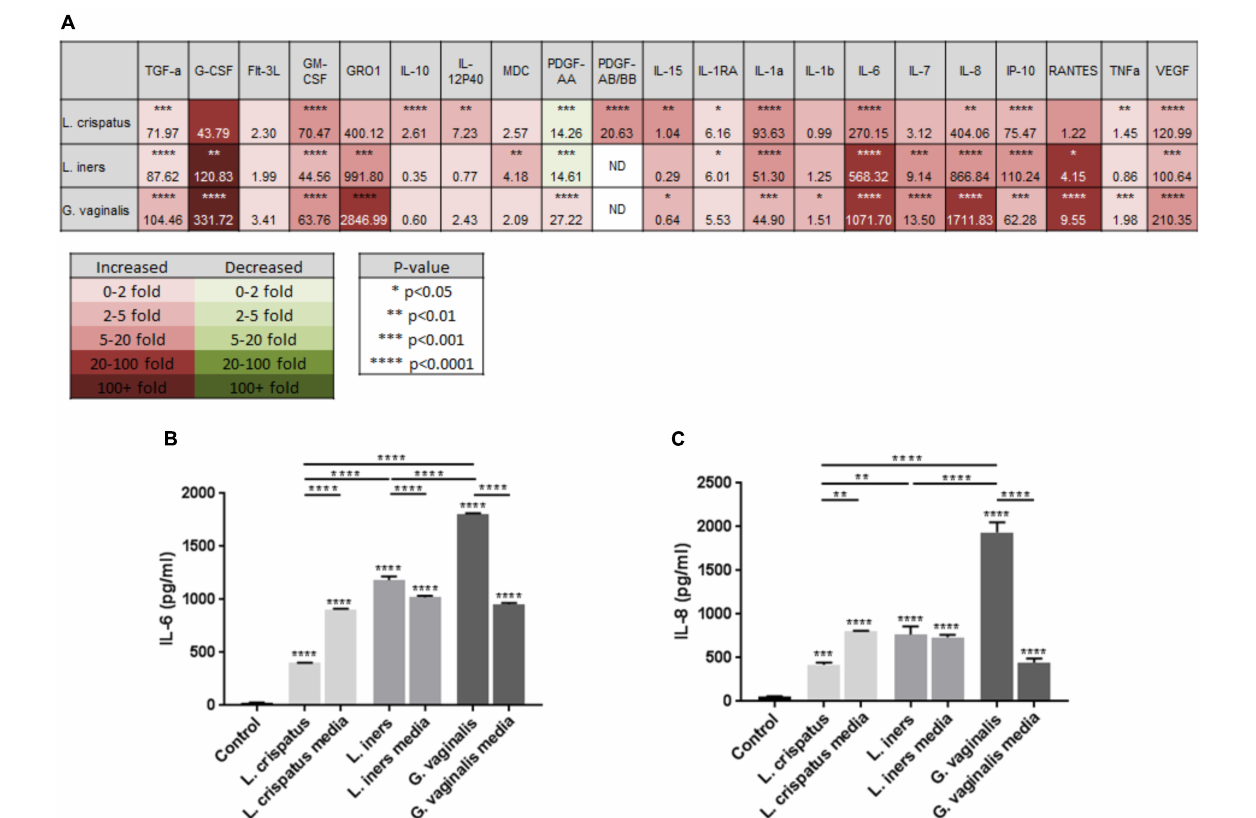
FIGURE 3 | Lactobacillus crispatus , L. iners , and G. vaginalis bacteria-free supernatants differentially alter the host epithelial immune response in ectocervical cells. Immune cytokines/chemokines released from ectocervical cells after exposure to L. crispatus , L. iners , and G. vaginalis bacteria-free supernatants (10% v/v) for 48 h were measured by Luminex (A) . Heat map depicts fold change by color, p -value by asterisks, and concentration (pg/ml) of each analyte by the number value present in each corresponding box. Validation of Luminex findings were performed for IL-6 (B) and IL-8 (C) in ectocervical cells exposed to L. crispatus , L. iners , and G. vaginalis bacteria-free supernatants or bacterial growth media alone. IL-6 and IL-8 were measured in ectocervical cell culture supernatants using a commercially available sandwich ELISA. Values are mean ± SEM. Asterisks over the individual bars represent comparisons to control; asterisks over solid lines represent comparisons between treatment groups. ∗ p < 0.05, ∗∗ p < 0.01, ∗∗∗ p < 0.001, ∗∗∗∗ p <